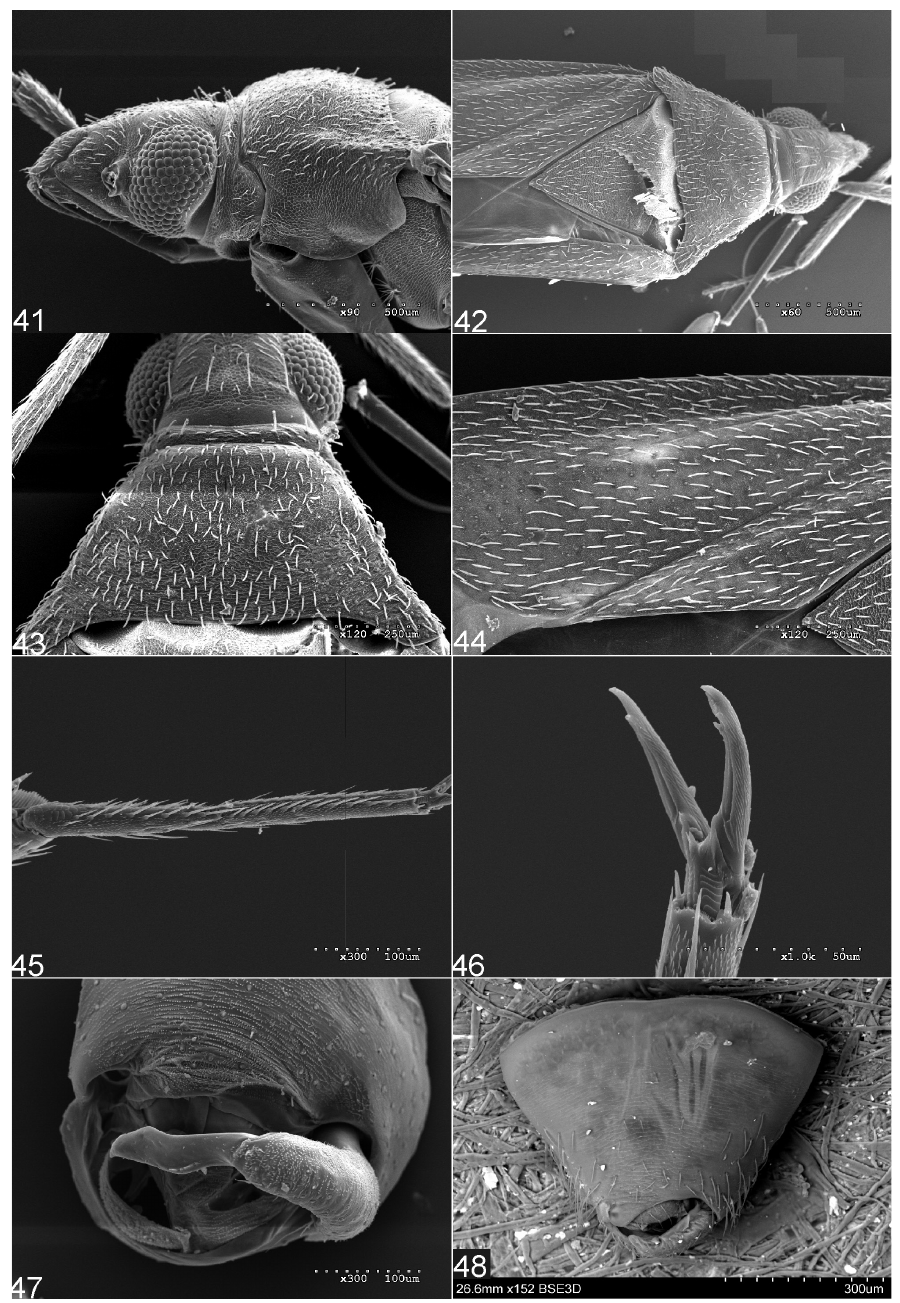
Figures 41–48. Scanning electron micrographs of anthocoroides group of species of the genus Fulvius : F. anthocoroides Stål ( 41, 45–47 ), F. pallens Gorczyca ( 42–44 ), F. urrlichi Sadowska-Woda & Gorczyca: ( 41 ). Head and pronotum (left lateral view) 42 Head, pronotum, and hemelytron (dorsal view) 43 Head and pro- notum (dorsal view) 44 Vestiture of hemelytron 45 Metatarsus 46 Pretarsal claw 47, 48 Male